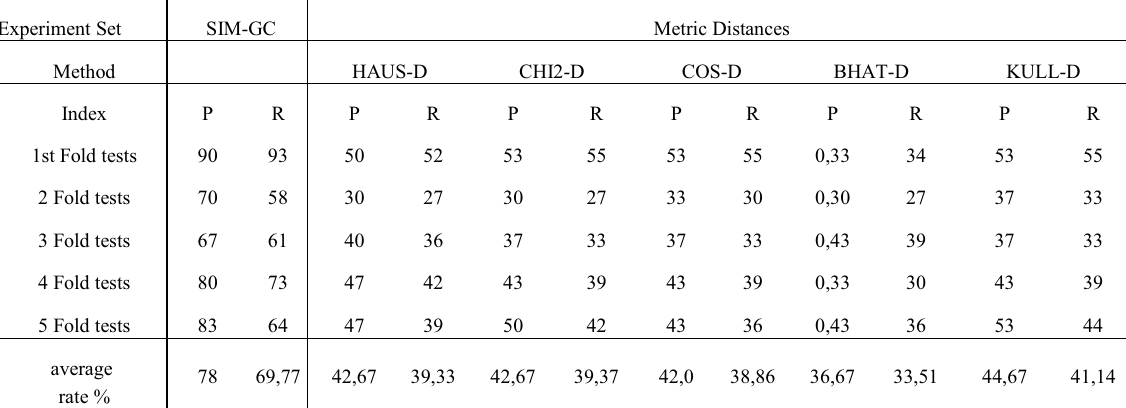
Table 4. Performance rates comparison with distance metrics (%)